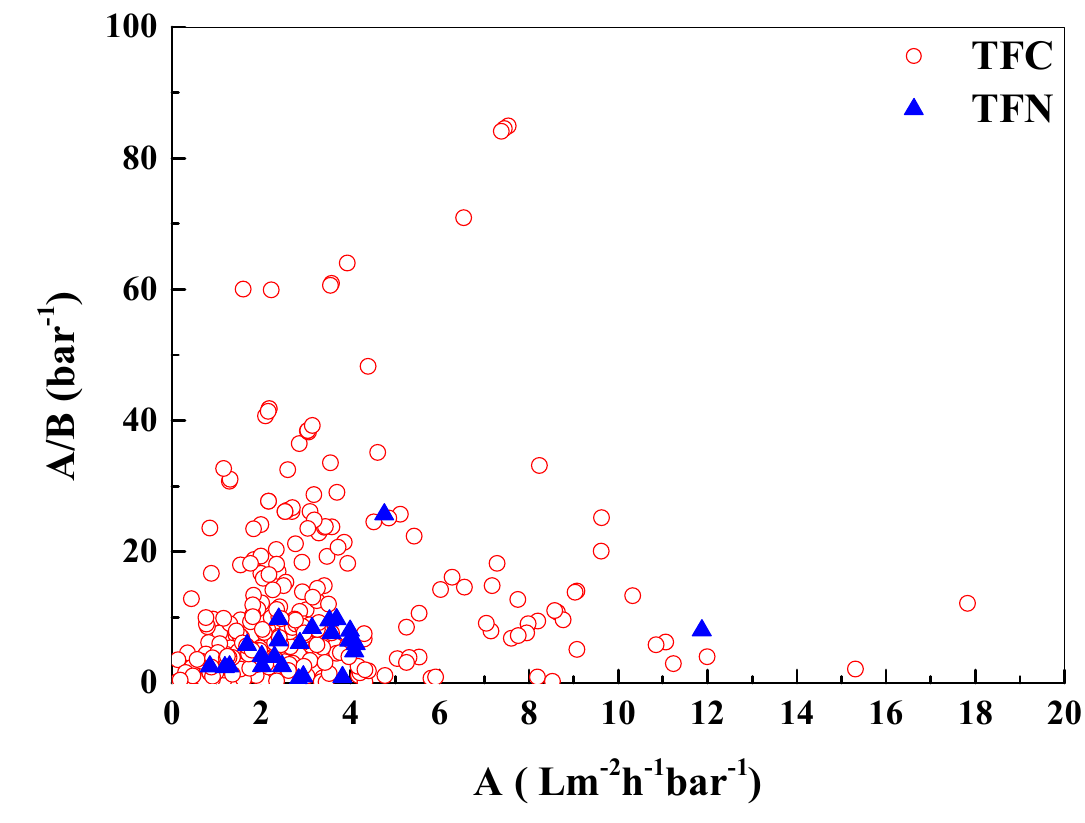
Figure 8. A / B vs. A of the TFC and TFN membranes collected from OMD (The Open Membrane Database).